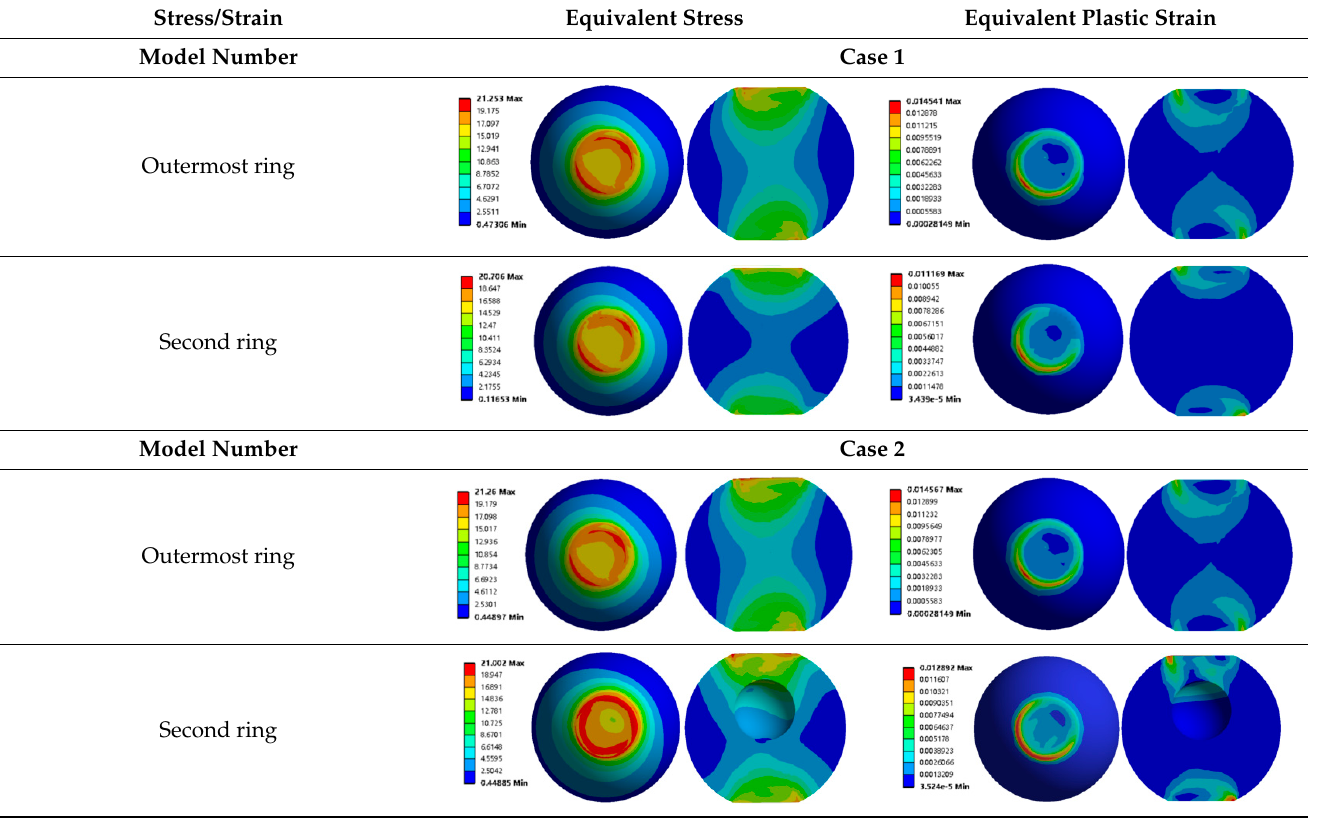
Table 6. Effect of the void on distribution of equivalent stress/strain of solder balls.